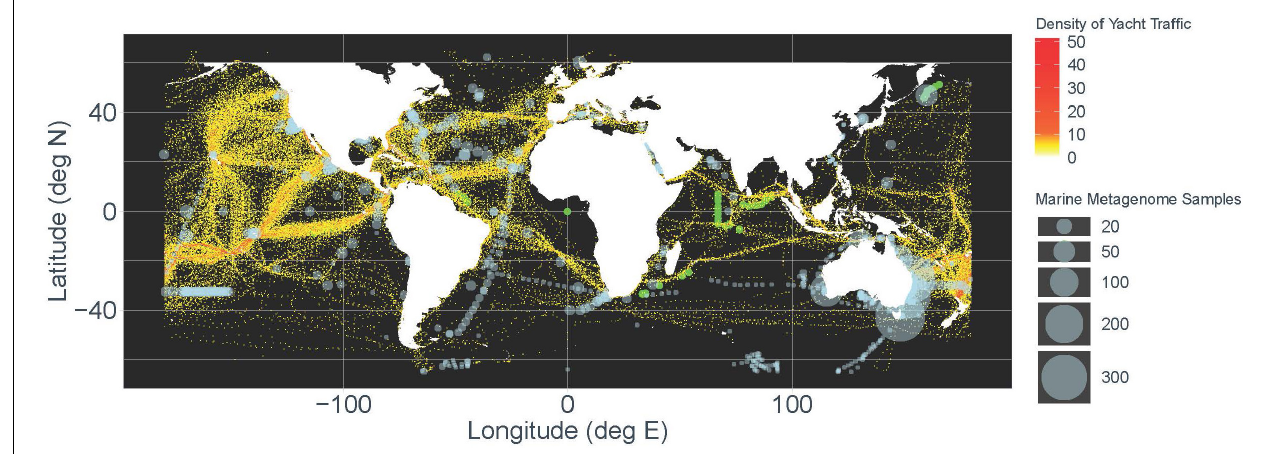
FIGURE 1 | The global map shows the current distribution and sample density of marine metagenomic samples highlighted in light blue (data sourced from the National Center for Biotechnology Information Sequence Read Archive), overlaid by a density plot of waypoints recorded for cruising yachts mapped by YOTREPS during the period 1999–2014. Metagenomics samples gathered by citizen scientists for IVE are highlighted in